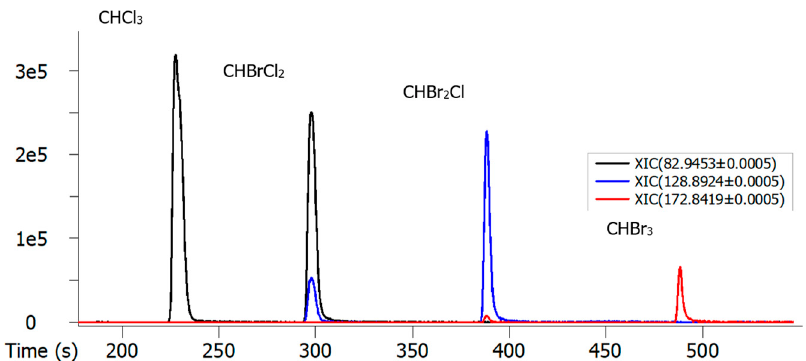
Figure 9. Ion chromatograms based on the characteristic ions of haloforms formed in aqueous chlorination of limonene at the ratio limonene/active chlorine 1:20. XIC means extracted ion chromatograms.